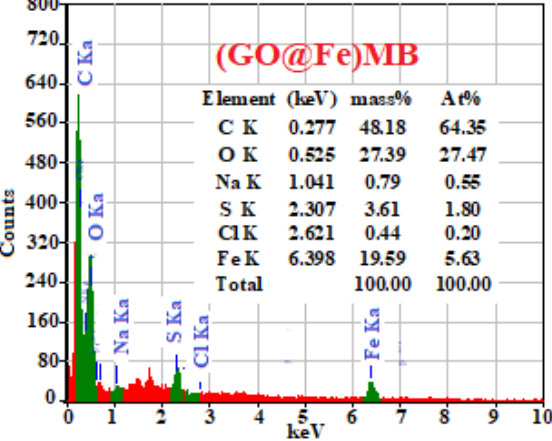
Figure 4. EDS analysis of GO @ M and (GO @ M)-MB, (M = Cu 2+ or Fe 3+ ).